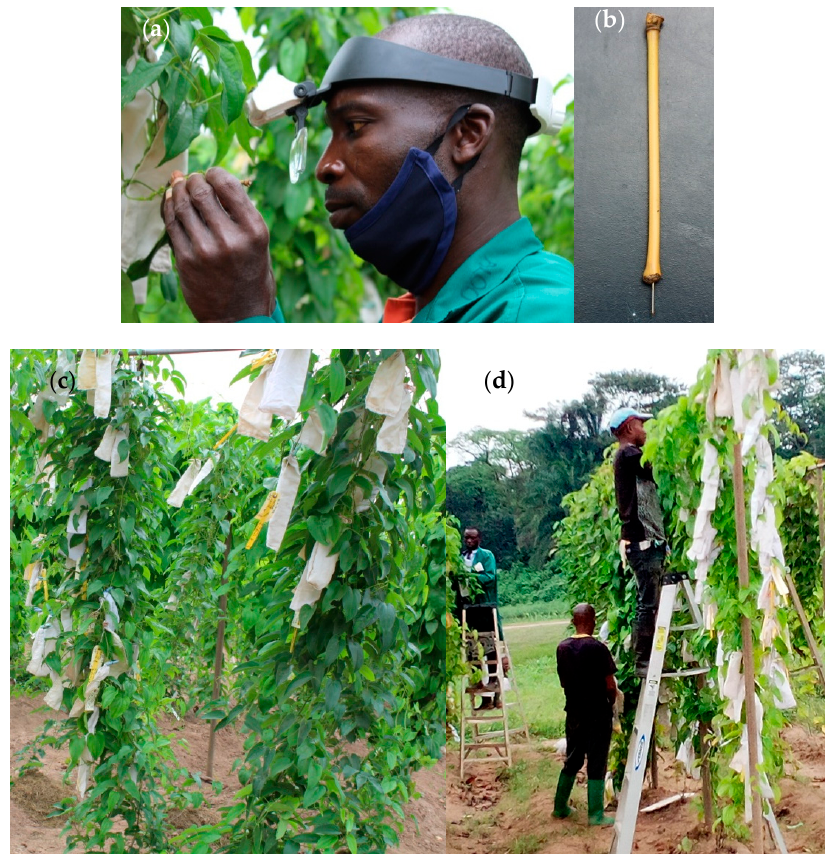
Figure 6. Some tools for increasing pollination e ffi ciency in yam breeding. ( a ) Use of magnifying glass to ease the di ffi culty of handling tiny flowers, ( b ) adapted pin for transfer of anthers to stigma, ( c ) thrip-proof cloth-bags allowing passage of oxygen, ( d ) ladder to reach all flowers in taller yam